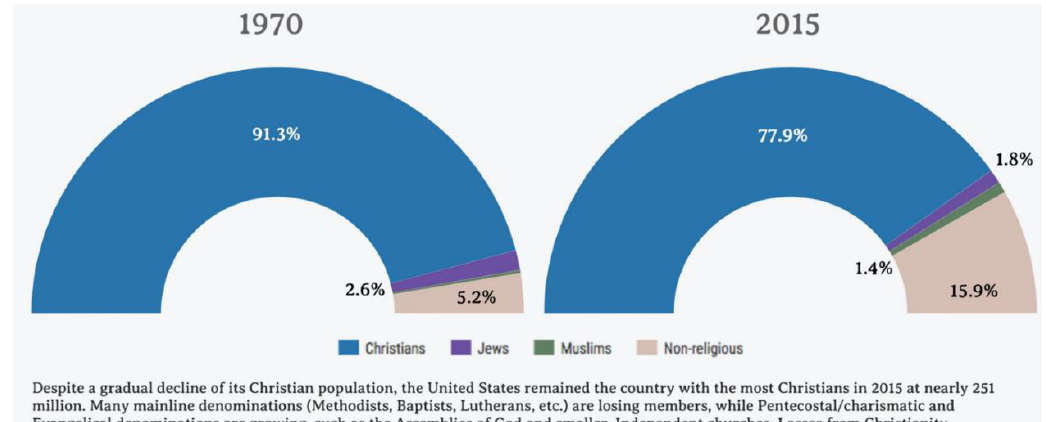
Figure 4. Religious diversity in Southeast Asia, 1970 and 2015.